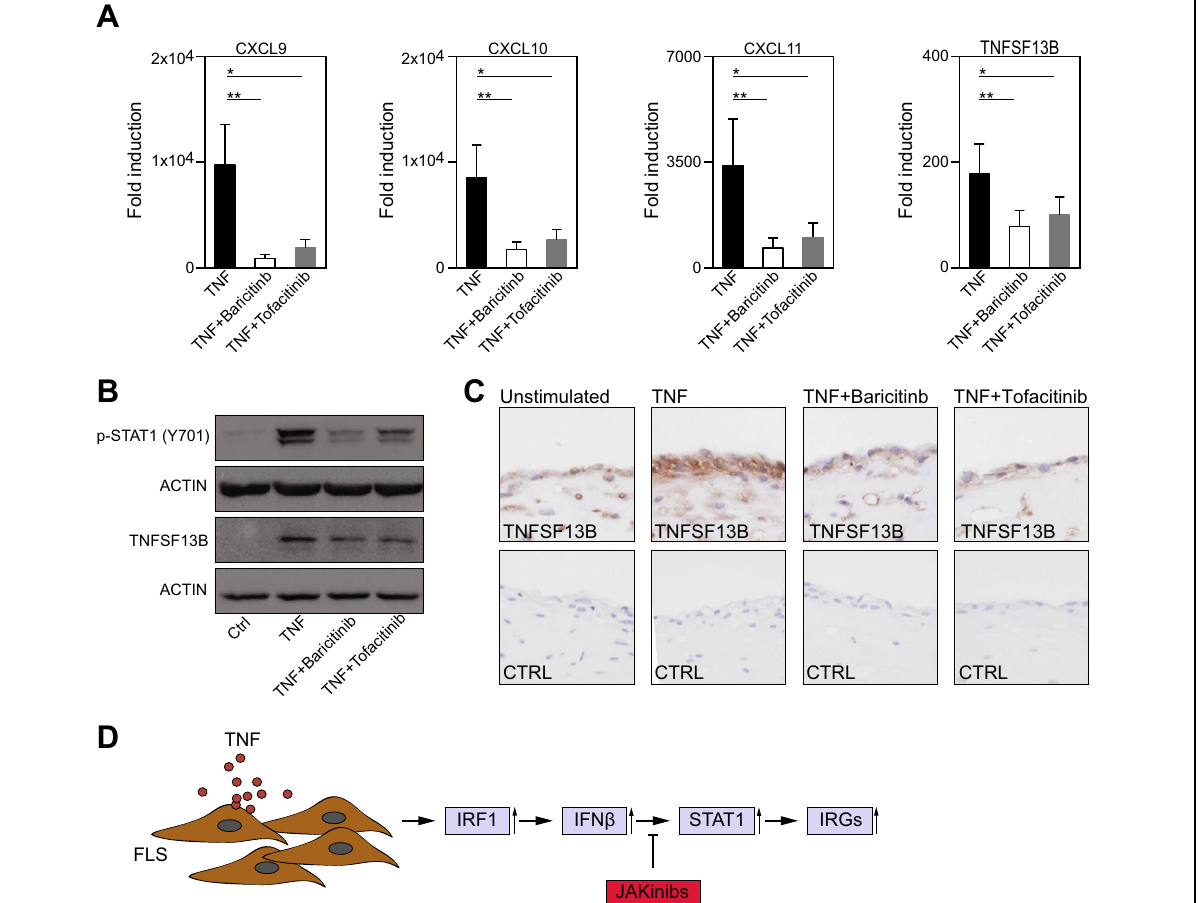
Fig. 5 JAKinibs inhibit the expression of CXCR3-binding chemokines and TNFSF13B. a RA-FLSs ( n = 7) were pretreated with DMSO, baricitinib (250nM) or tofacitinib (250nM) for 1 h and then stimulated with TNF (10 ng/ml) for 6 h. Gene expression was determined by qPCR. Expression in the treated cells is presented relative to that in the unstimulated cells. Values are shown as the mean ± SEM. * p < 0.05, ** p < 0.01; Wilcoxon matched-pairs test. b RA-FLSs were pretreated with DMSO, baricitinib (250 nM) or tofacitinib (250nM) for 1 h and then stimulated with TNF (10 ng/ml) for 24 h. Western blots representative of at least four experiments with different RA-FLS cell lines are shown. c RA-FLSs were cultured in micromass organ cultures for 8 days. After serum starvation overnight, the FLSs were treated with DMSO (Unstimulated), TNF (10 ng/ml) + DMSO, TNF (10 ng/ml) + baricitinib (250 nM) or TNF (10 ng/ml) + tofacitinib (250 nM) for 24 h. Micromasses were fi xed, sectioned and stained with hematoxylin and a speci fi c antibody against TNFSF13B (brown staining). Images representative of four independent experiments performed with FLSs from four different RA patients are shown. d The schematic representation of the TNF-induced pathway in FLSs is shown (JAKinib = Janus Kinase inhibitor; IRG =